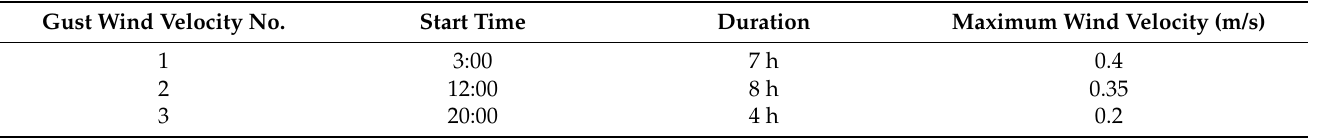
Table A9. Parameters of the gust wind velocity in Scenario III in the case study. Gust Wind Velocity No.